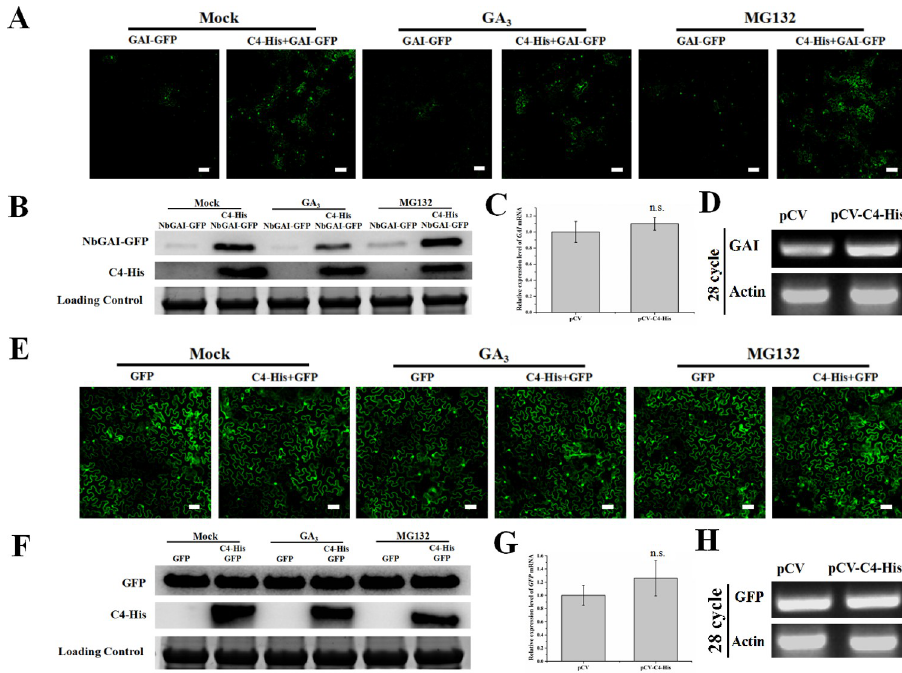
Fig 6. ALCScV C4 can inhibit NbGAI degradation in vivo . (A) NbGAI-GFP was transiently co-expressed with empty vector or C4-His in N . benthamiana leaves. GA 3 (50 μ M) and MG132 (50 μ M) were applied to the infiltrated leaves 2 h and 12 h before observation, respectively. At 48 hpi, the assayed leaves were harvested and examined under a confocal microscope. Scale bar = 200 μ m. (B) Results of the Western blot analysis show the relative accumulation level of NbGAI-GFP. The blots were probed with an anti-GFP or an anti-His antibody. The CBB-stained RuBisCo large subunit gel shows equivalent sample loadings. (C) and (D) Results of qRT-PCR and semi-qRT-PCR analyses show the relative expression level of NbGAI . The expression level of NbActin was used as an internal control. The qRT-PCR results were analyzed using the 2 - ΔΔ Ct method. (E) ALCScV C4 does not affect the stability of GFP in vivo . Scale bar = 200 μ m. (F) Results of the Western blot analysis show the relative accumulation level of GFP in the mock-, GA 3 - or MG132-treated plant leaves. (G) and (H) Results of qRT-PCR and semi-qRT-PCR show the relative expression level of the GFP gene. ns indicates not significant according to Student’s t